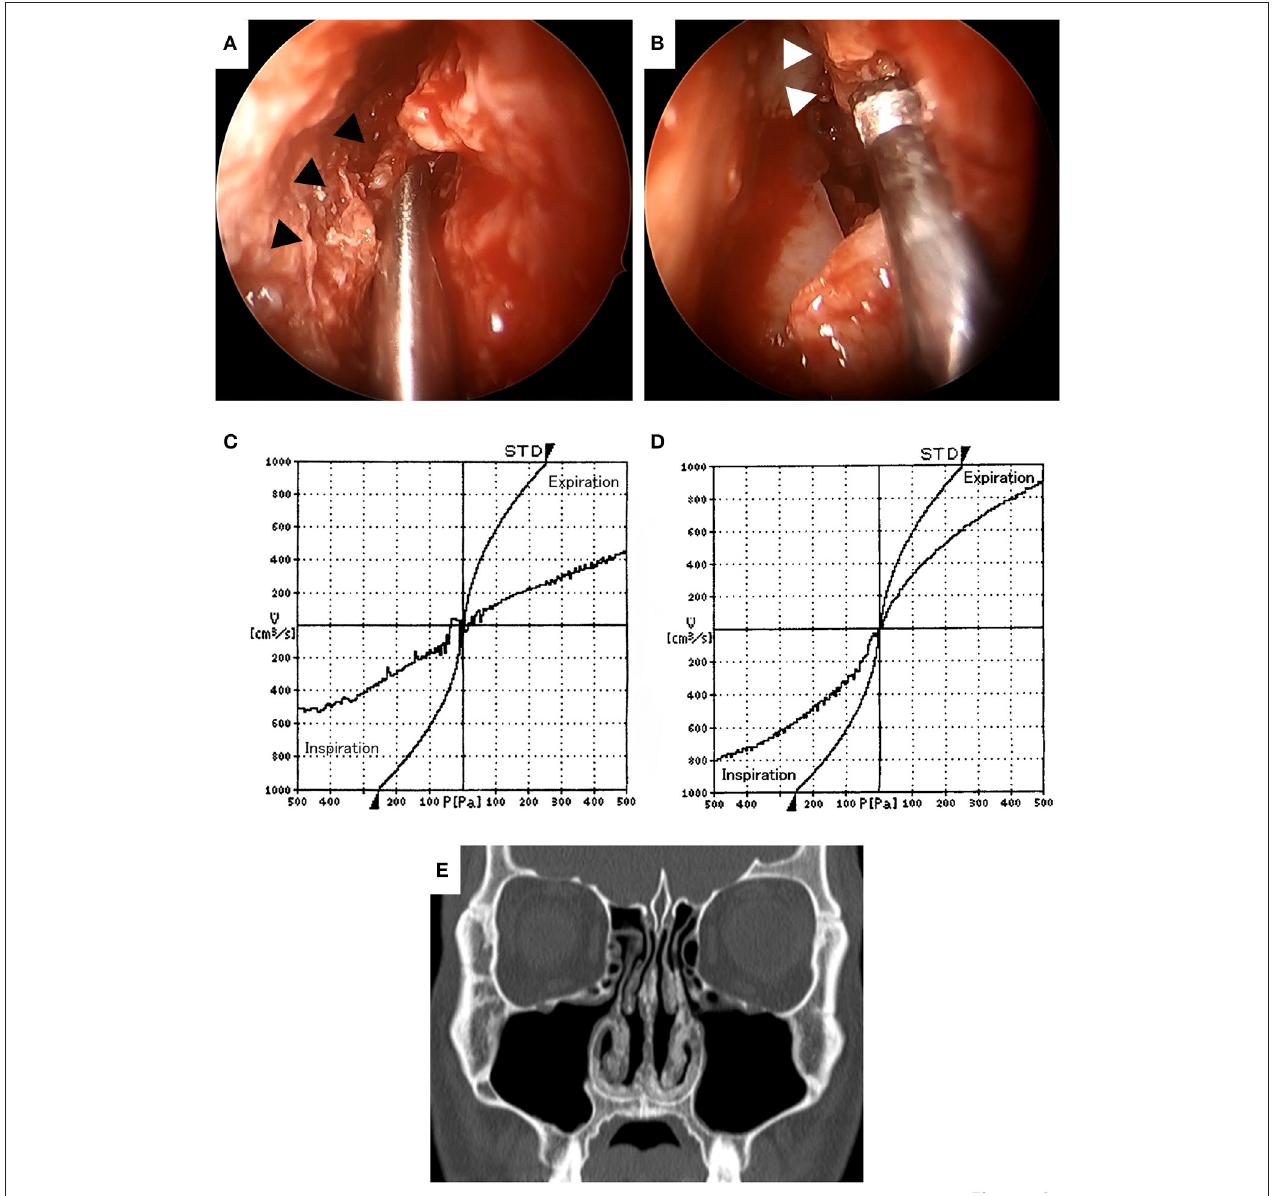
FIGURE 3 | Intraoperative findings (A,B) . The submucosal tissue with severe calcification ( N ) was very hard and difficult to resect with the turbinate blade of a microdebrider (A) . Hard submucosal tissue with calcification ( 1 ) was resected with an ultrasonic bone curette to preserve as much of the mucosal surface as possible (B) . Comparison of preoperative (C) and postoperative (D) rhinomanometry results at 6 months. The nasal resistance in both nostrils was improved after surgery. Computed tomography at 6 months after surgery (E) . Deviation of the nasal septum, mucosal thickening of the septum and bilateral inferior turbinates was improved and the bilateral common nasal meatuses were